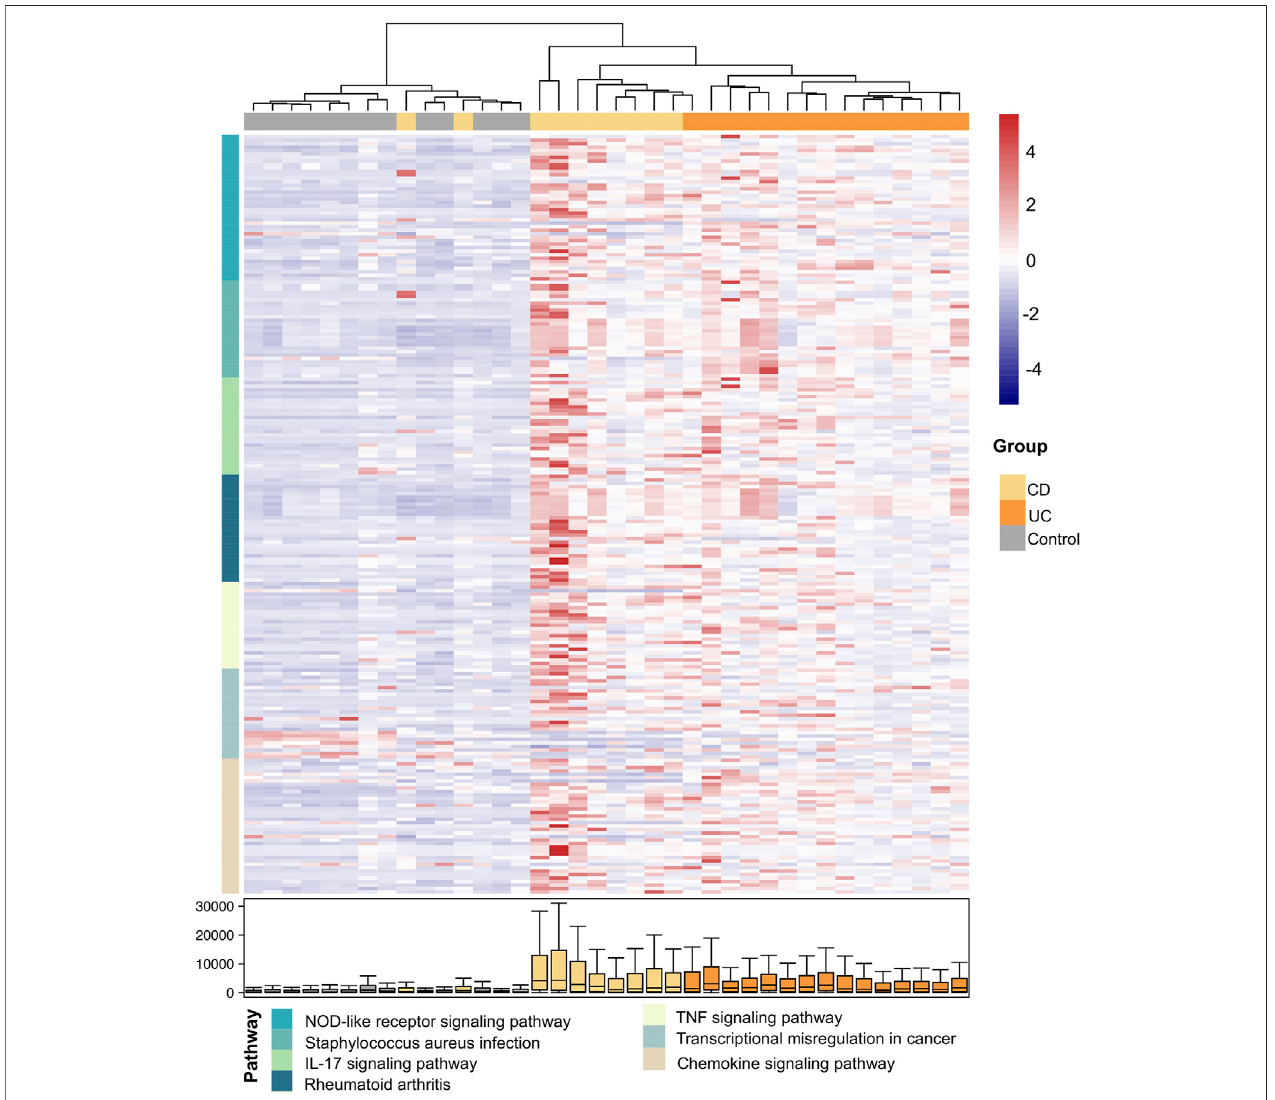
FIGURE4 | Expression heatmap ofthe DEGs in the DEPs between CD and UC. The samplesand the DEGs are presented in columns and rows, respectively. The color ofthe DEGs inrows indicates different DEPs asspeci fi ed in thefollowing (pathway). Thecolor bar on the right side indicates the scaled expressionsofthesegenes in each sample. The distribution of the expressions for each DEG is shown by boxplot at the bottom.